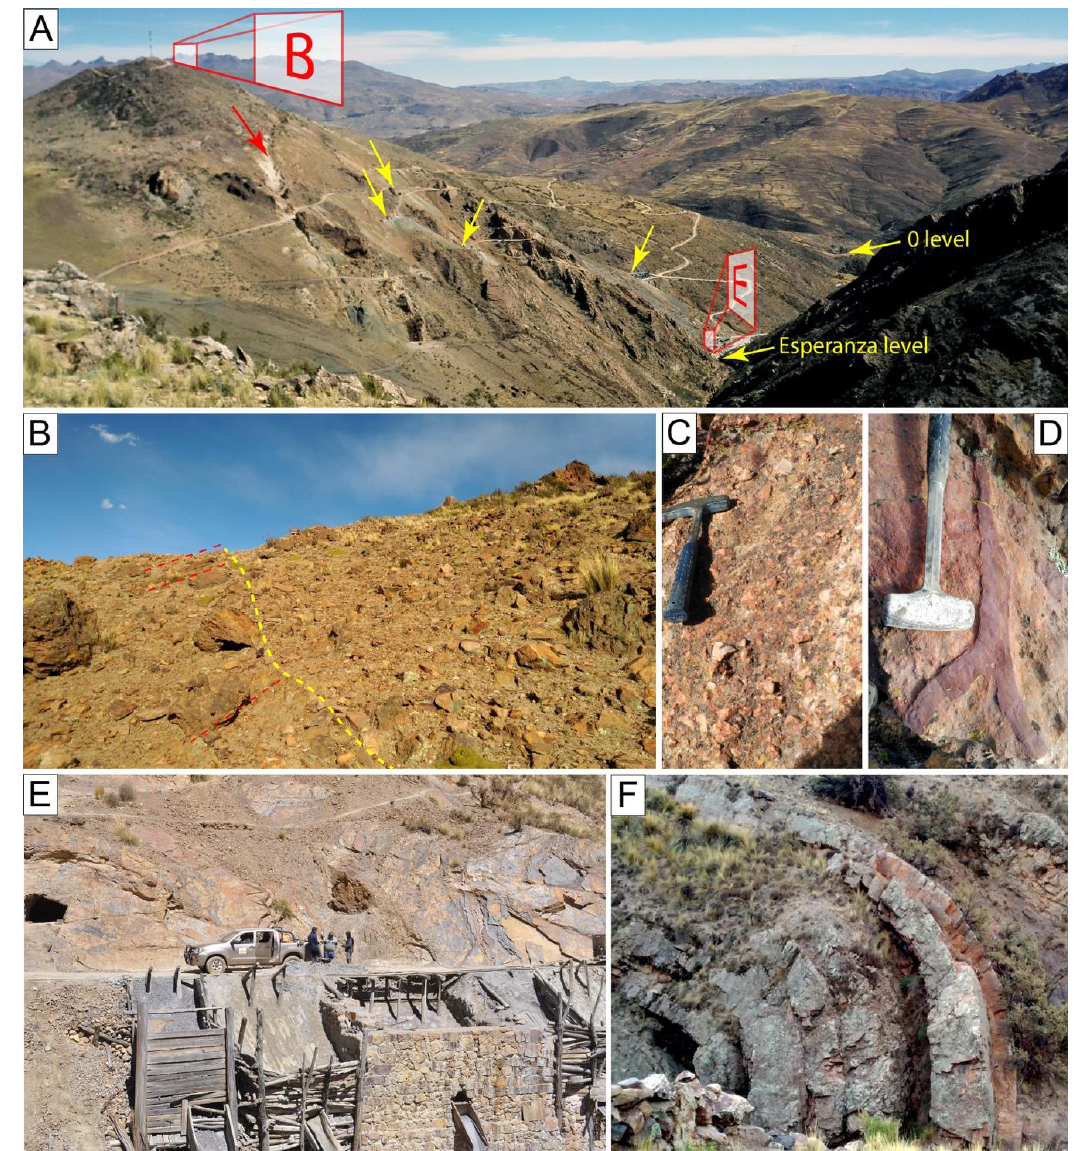
Figure 3. Field photographs illustrating structures, lithologies, and textures of hosting rocks in the Huari Huari district. ( A ) General, SW-looking view of the Cerro Vera Cruz hill, hosting most of the Antón Bravo vein; notice the trace of the vein on the surface, which is picked out by open stopes, pits (red arrow), adits, and waste dumps (yellow arrows). ( B ) Contact (dashed yellow line) between Paleozoic metamorphosed sedimentary strata (left, red dashed line) and a dacite dome (right) in Cerro Manto hill, which hosts a large portion of the Buen Suceso vein; see location of the picture in A. ( C ) Dacite breccia observed in the Cerro Manto hill. ( D ) Deep red aplite dikes cut massive dacites in the Cerro Manto hill. ( E ) Esperanza level adit, close to the Huari Huari village; notice that the gallery is dug in Silurian shales of the Uncía formation. ( F ) Folded Ordovician quartzites of the San Benito formation in the core of the Huari Huari anticline.